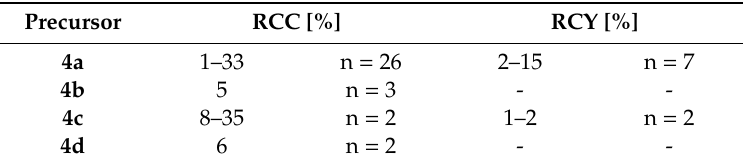
Table 1. One-step labeling procedure to synthesize [ 18 F]SFB.